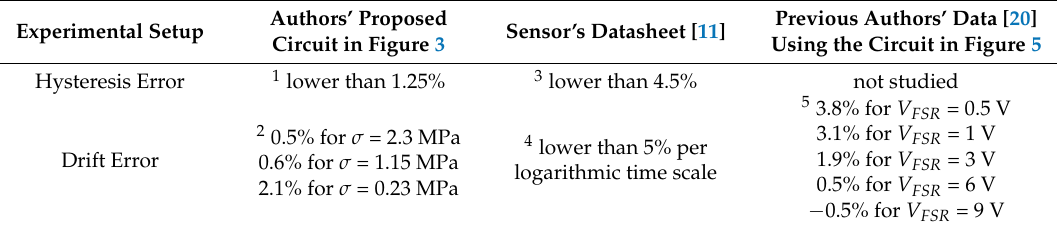
Table 2. The comparative performance of the authors’ proposed circuit with information from the sensor’s datasheet [11]. Previous authors’ data are also reported for comparison purposes